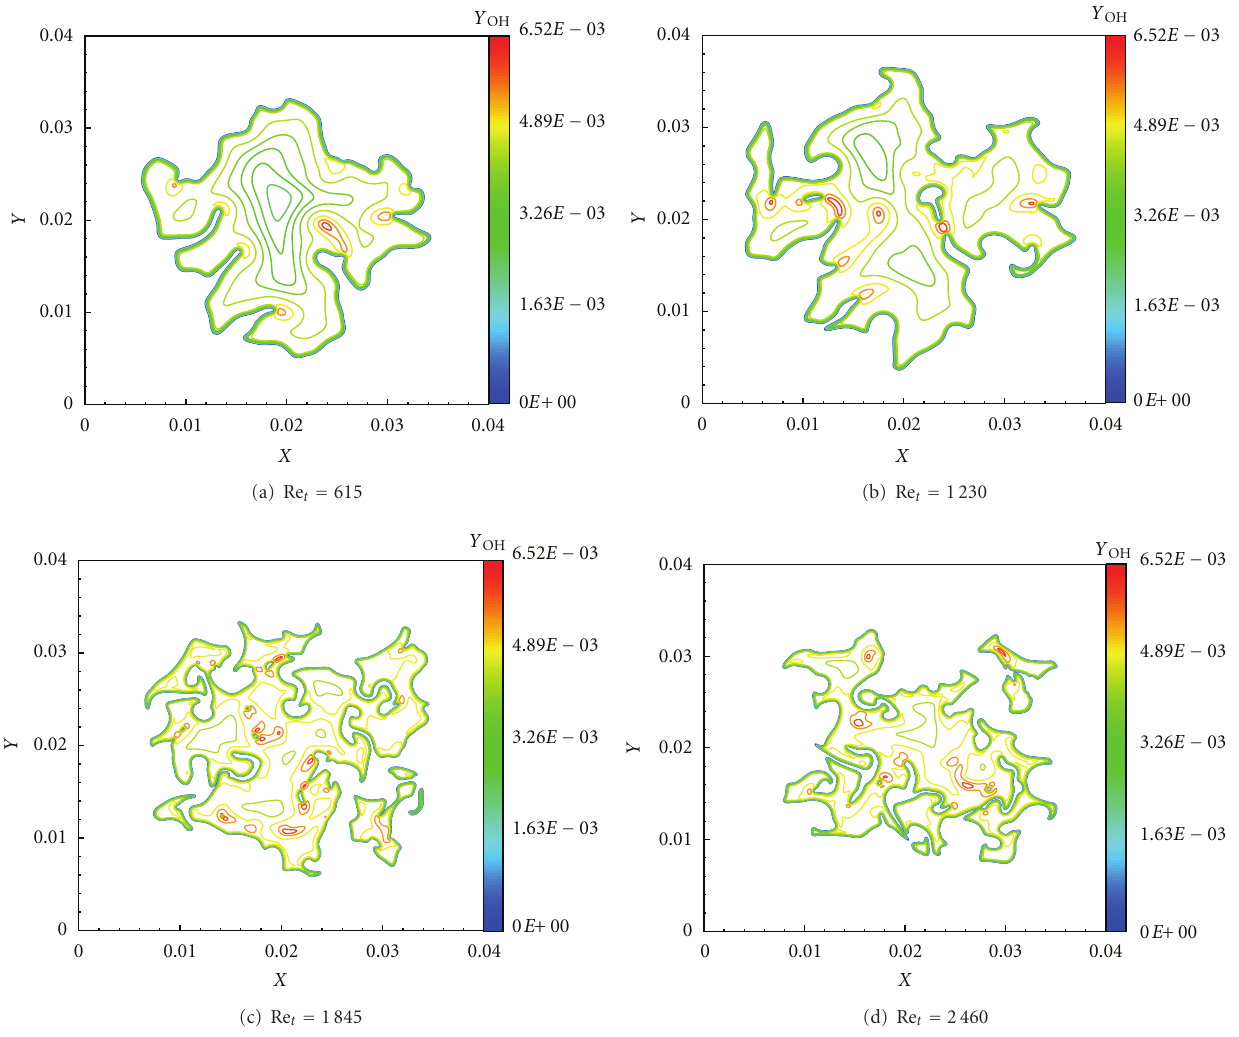
Figure 7: Instantaneous iso-contours of OH mass fraction (along the z = 2 . 0cm plane) when increasing turbulent Reynolds number Re t at t = 1 . 2 τ . Identical colors are used for all